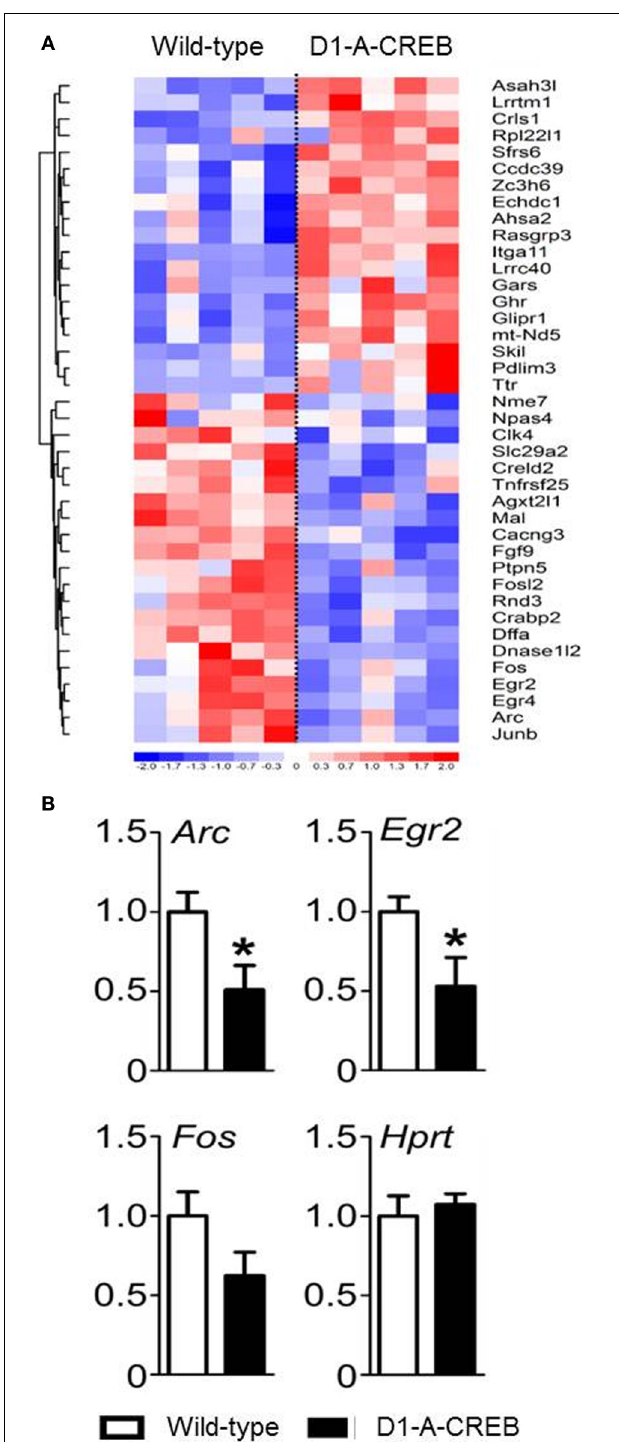
FIGURE 3 | Effect of A-CREB transgene on the induction of activity-dependent genes. (A) The heatmap summarizes results from gene expression profiling in the striatum of wild-type ( n = 5) and D1-A-CREB ( n = 5) mice using Illumina MouseWG-6 v2 BeadChip arrays. The 40 transcripts included in the heatmap are the top 20 most significantly